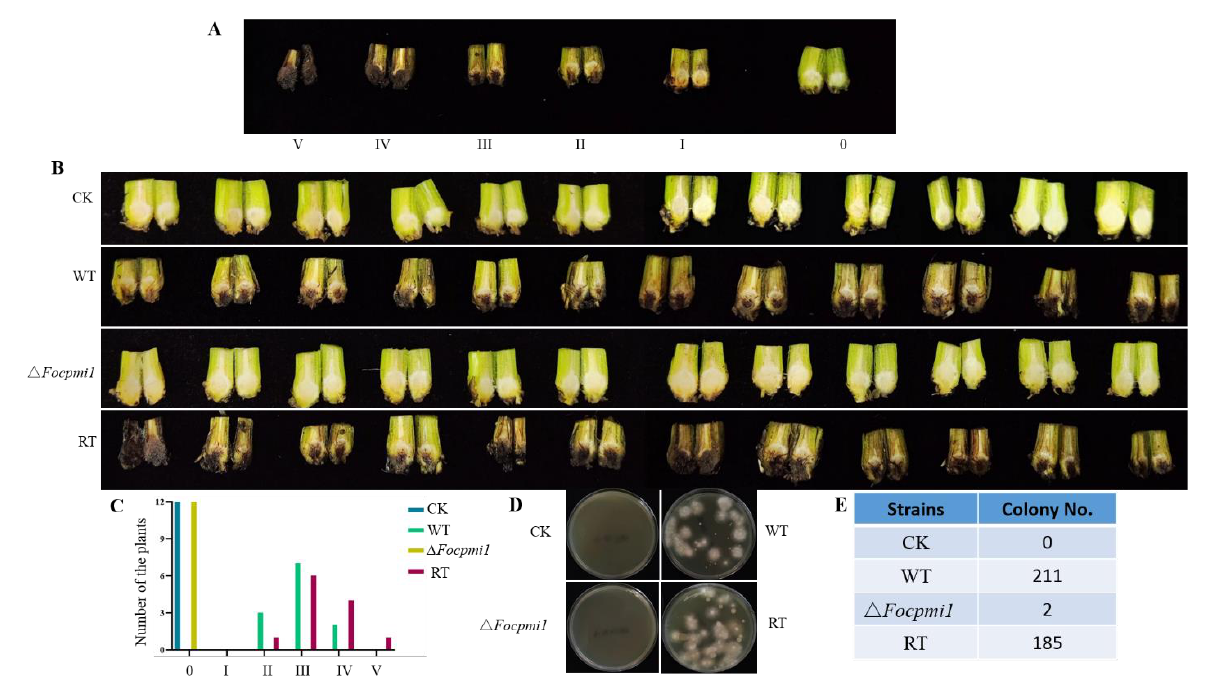
Figure 7. Rhizome wilt symptoms from the susceptible banana plants infected by the indicated strains. ( A ) Grading of rhizome browning from 0 (no symptoms) to V (complete browning). ( B ) The browning degree in banana rhizome tissue after 28 days inoculation with WT, ∆ Focpmi1 , RT, and CK groups. ( C ) Number of the plants developing rhizome disease severity from each infected group. ( D ) Fungal burden recovered from the rhizomes of banana plants infected with each indicated strain. ( E ) Number of fungal colonies recovered after culturing the ground rhizome infected with the indicated strains.